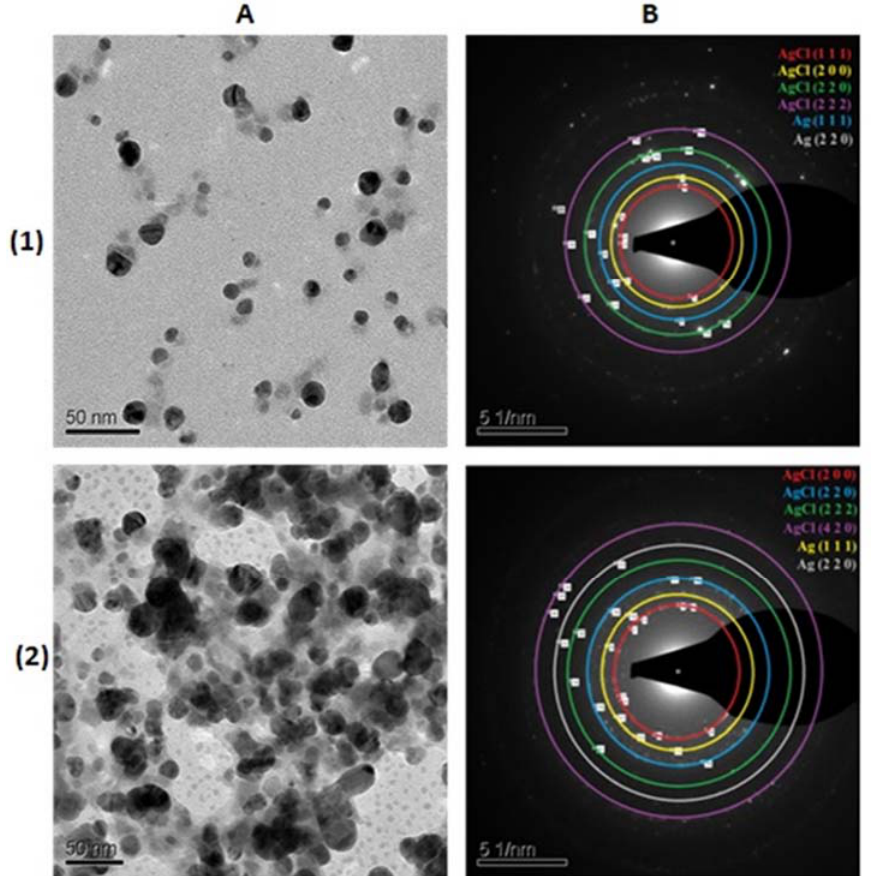
Figure 3. ( A ) Transmission electron microscopy (TEM) images of silver chloride nanoparticles (scale bar: 50 nm) and ( B ) selected area electron diffraction (SAED) pattern of Ag/AgCl nanoparticles biosynthesized by ( 1 ) Raoultella planticola and ( 2 ) Pantoea agglomerans .